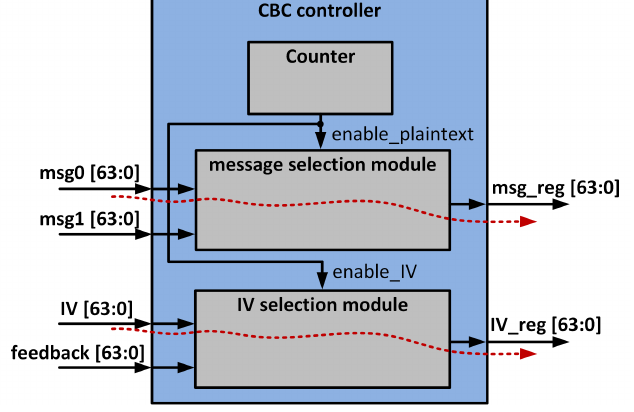
Figure 4. Hardware architecture of the CBC controller